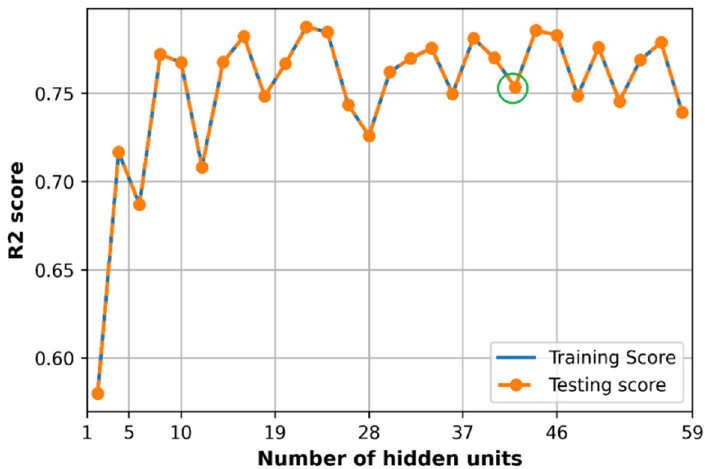
Figure 22. Comparison of accuracy with different the number of hidden units.